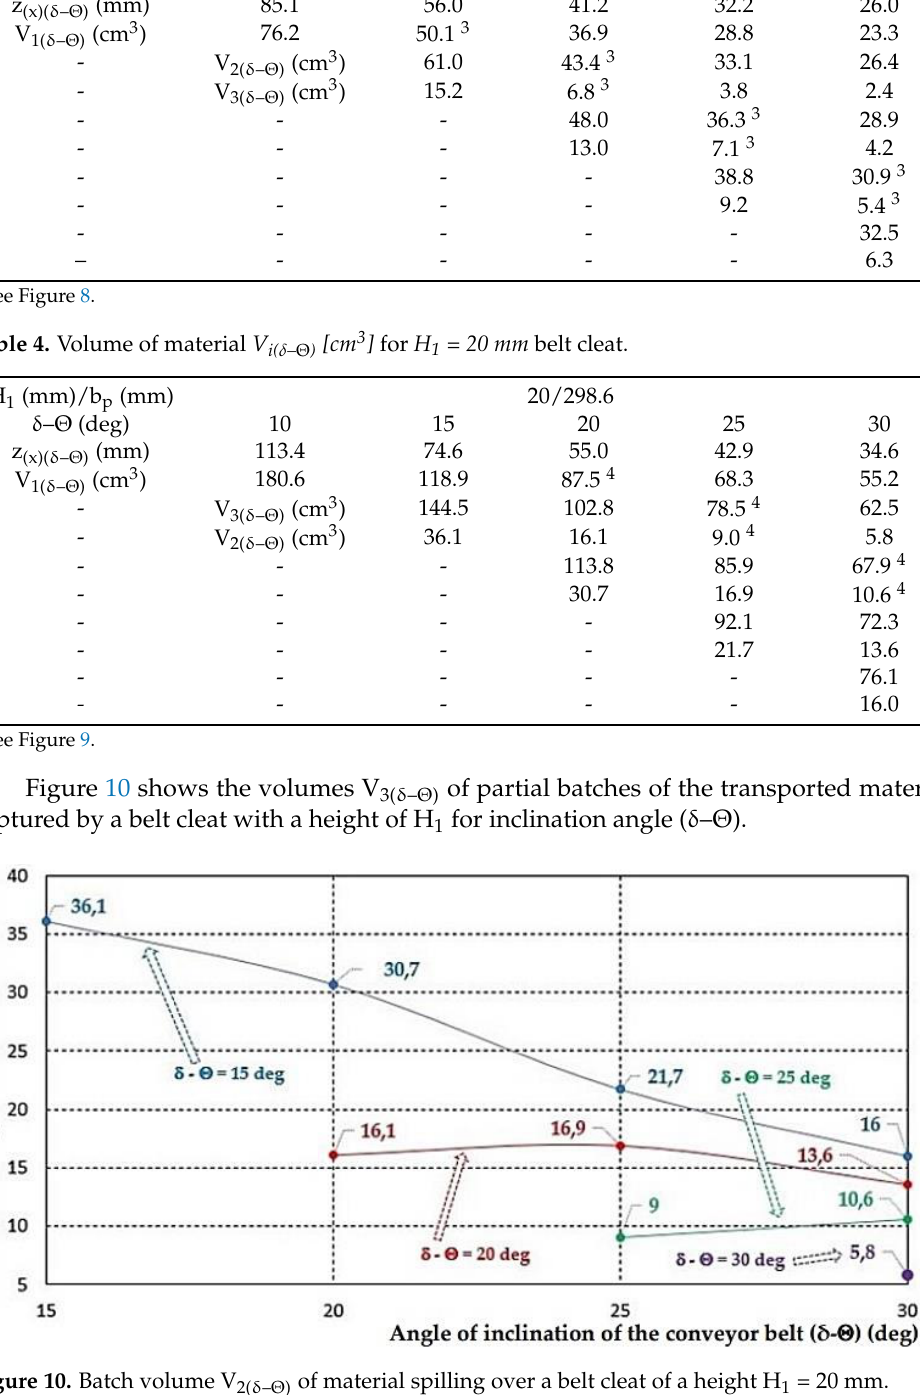
Figure 10. Batch volume V 2( δ–Θ ) of material spilling over a belt cleat of a height H 1 = 20 mm.